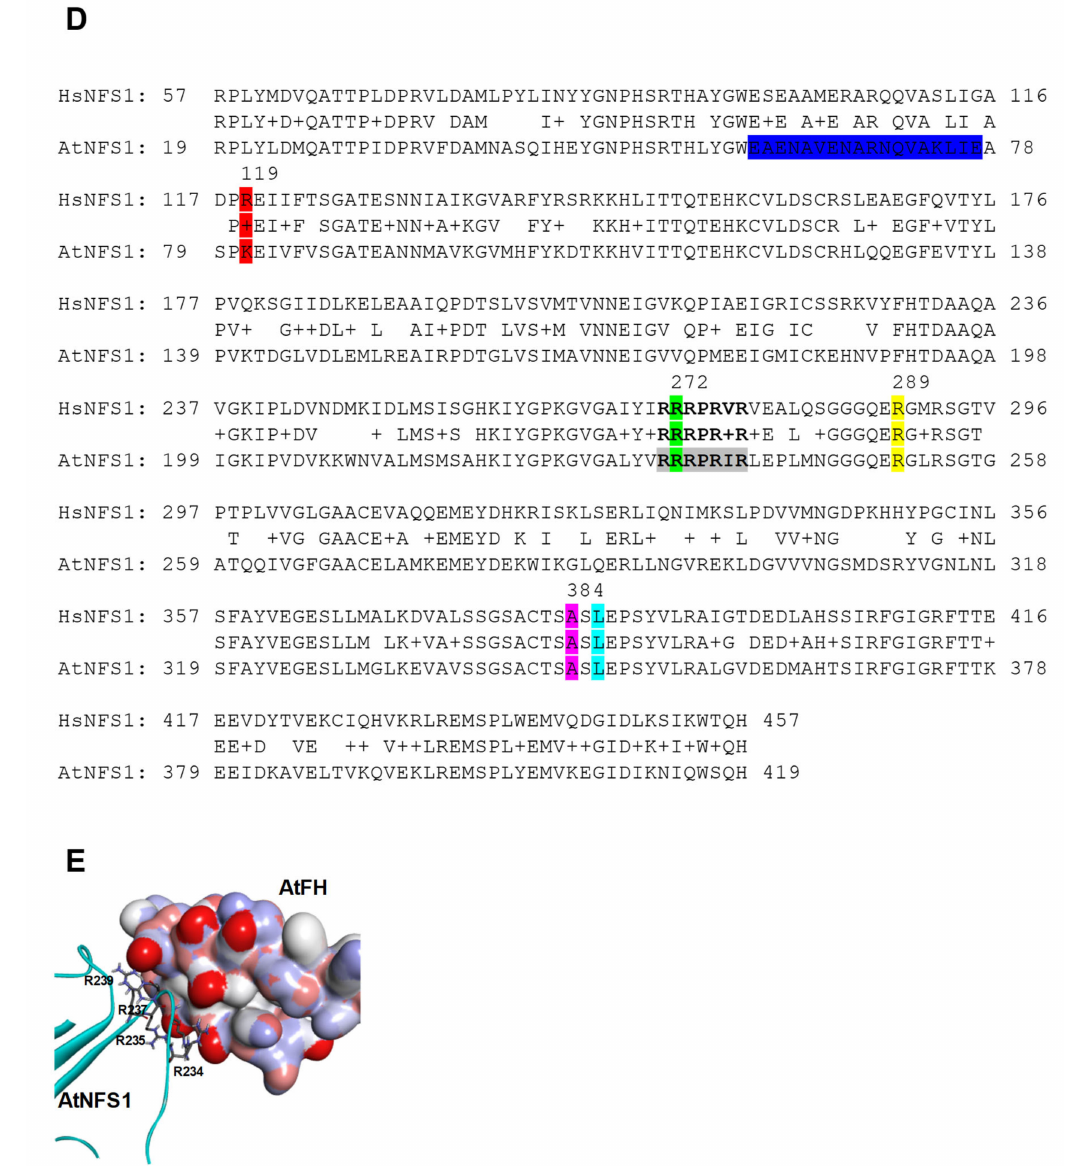
Figure 3. Homology modeling of iron–sulfur cluster (ISC) complex and docking studies. ( A ) Surface and ( B ) ribbon models of the protein complex formed by AtNFS1 (light blue), AtISD11 (red), and AtFH (yellow). The docking model was predicted using HADDOCK 2.4. ( C ) Amino acid sequence alignment of human (FXN) and Arabidopsis frataxin (AtFH) and ( D ) human (HsNFS1) and Arabidopsis (AtNFS1) cysteine desulfurases. The amino acids highlighted with color in ( C ) interact with the amino acid with the same color in ( D ). The amino acids marked in grey in ( C ) are part of the negatively charged patch in AtFH. Amino acids marked in grey in D are part of the Arg-rich patch in AtNFS1, and those marked in blue are part of the negatively charged helix region that interacts with the α 2-helix from AtISD11. ( E ) Interaction of the acidic AtFH patch with Arg residues on